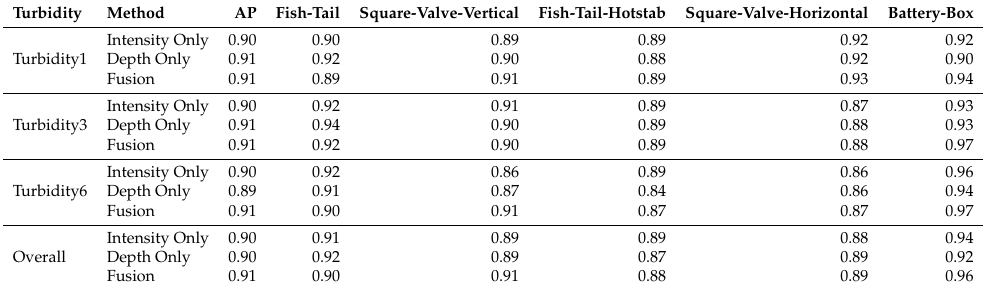
Table 2. Two-dimensional Object detection performance (AP) using intensity, depth,